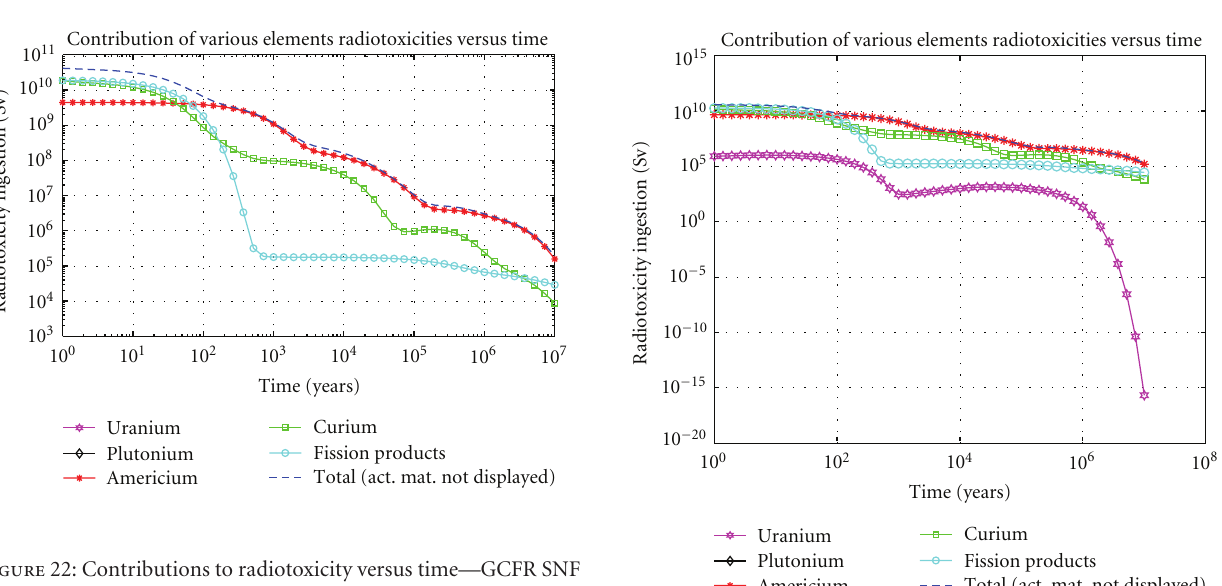
Figure 22: Contributions to radiotoxicity versus time—GCFR SNF end fourth cycle.